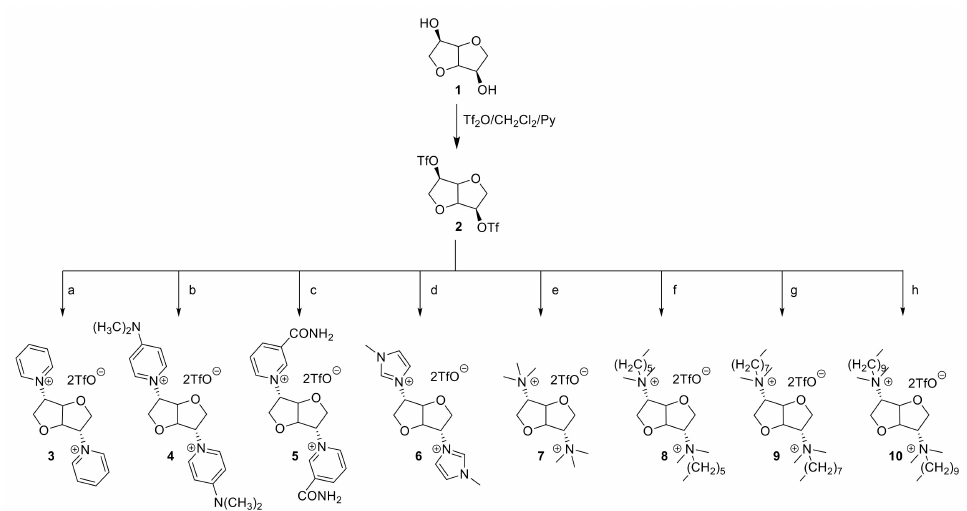
Scheme 1. Synthesis of gemini QAS derivatives of 1,4:3,6-dianhydro- L -iditol. Reaction con-